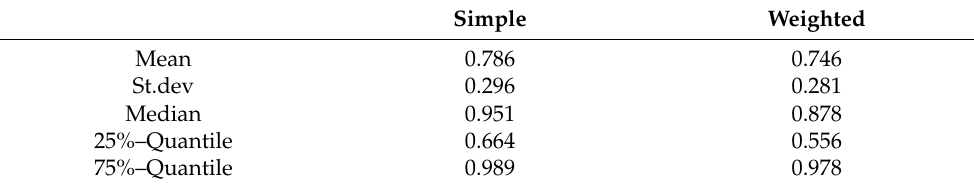
Table 1. Basic statistics of recovery rates.